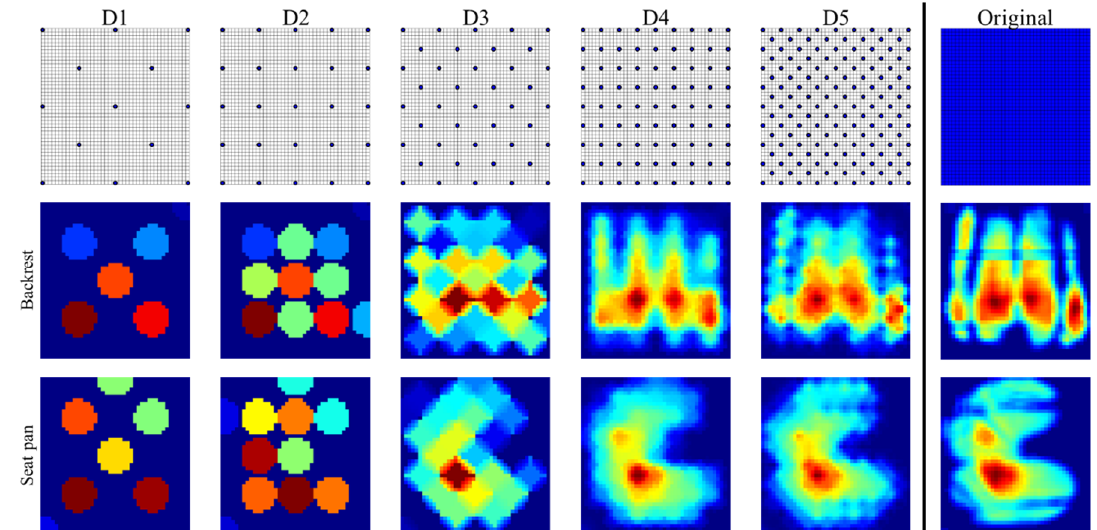
Figure 5. New pressure sensor layouts and interpolated BPD for backrest and seat pan. The first row shows different pressure sensor layouts, while the interpolated pressure distributions for backrest and seat pan are shown in the second row and the third row, respectively.